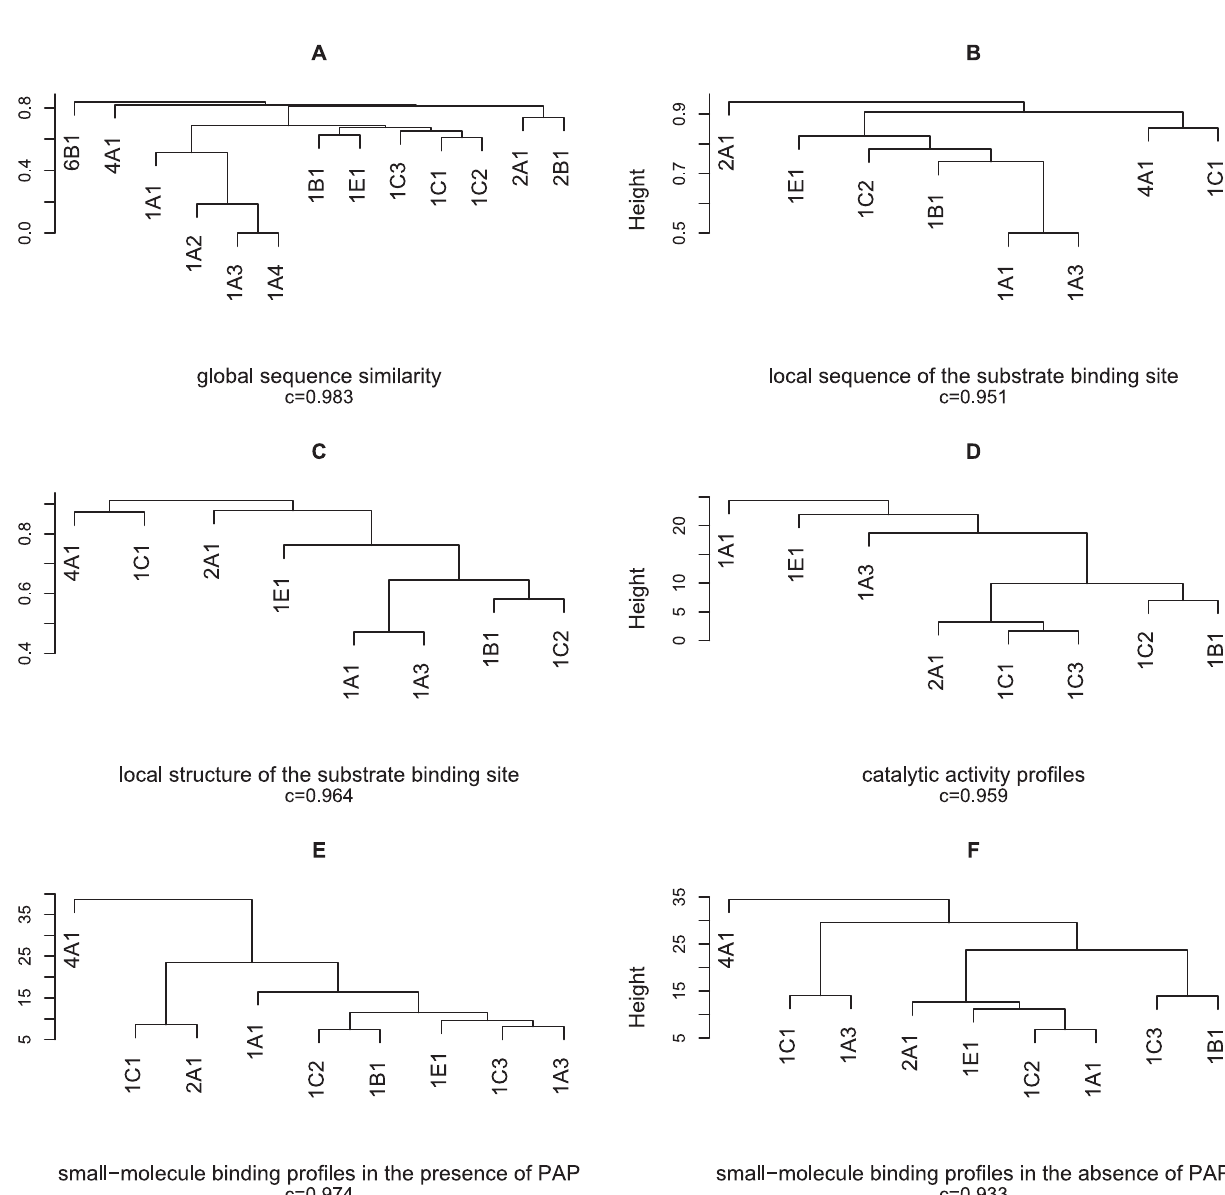
Figure 8. Average Linkage Hierarchical Clustering of SULTs Clustering is shown according to (A) global sequence similarity, (B) local sequence of the substrate binding site, (C) local structure of the substrate binding site, (D) catalytic activity profiles, (E) small molecule binding profiles in the presence of PAP, and (F) small molecule binding profiles in the absence of PAP. The value under each clustering (c) is the correlation between the original data matrix and the cophenetic matrix—a matrix whose elements represent the height at which these elements first meet in the tree. The higher this correlation, the more accurate the tree represents the original data. See Materials and Methods for further details.